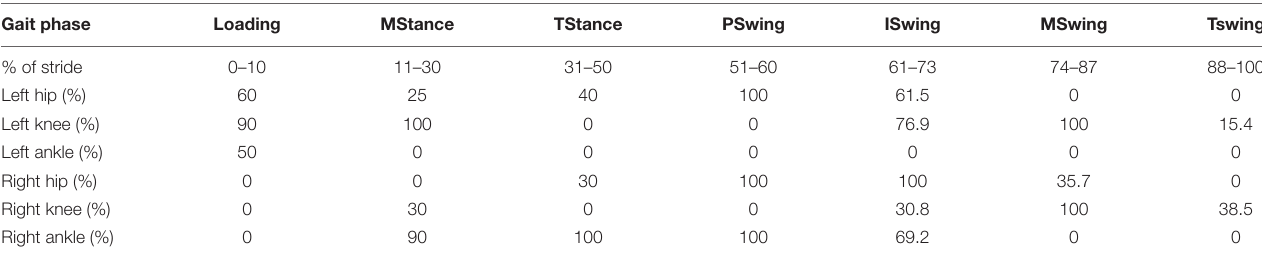
TABLE 5 | The results of SPM analyses between the same joints of the two participants separated by gait cycle phases (see Table 4 ’s legend for phase labels). Gait